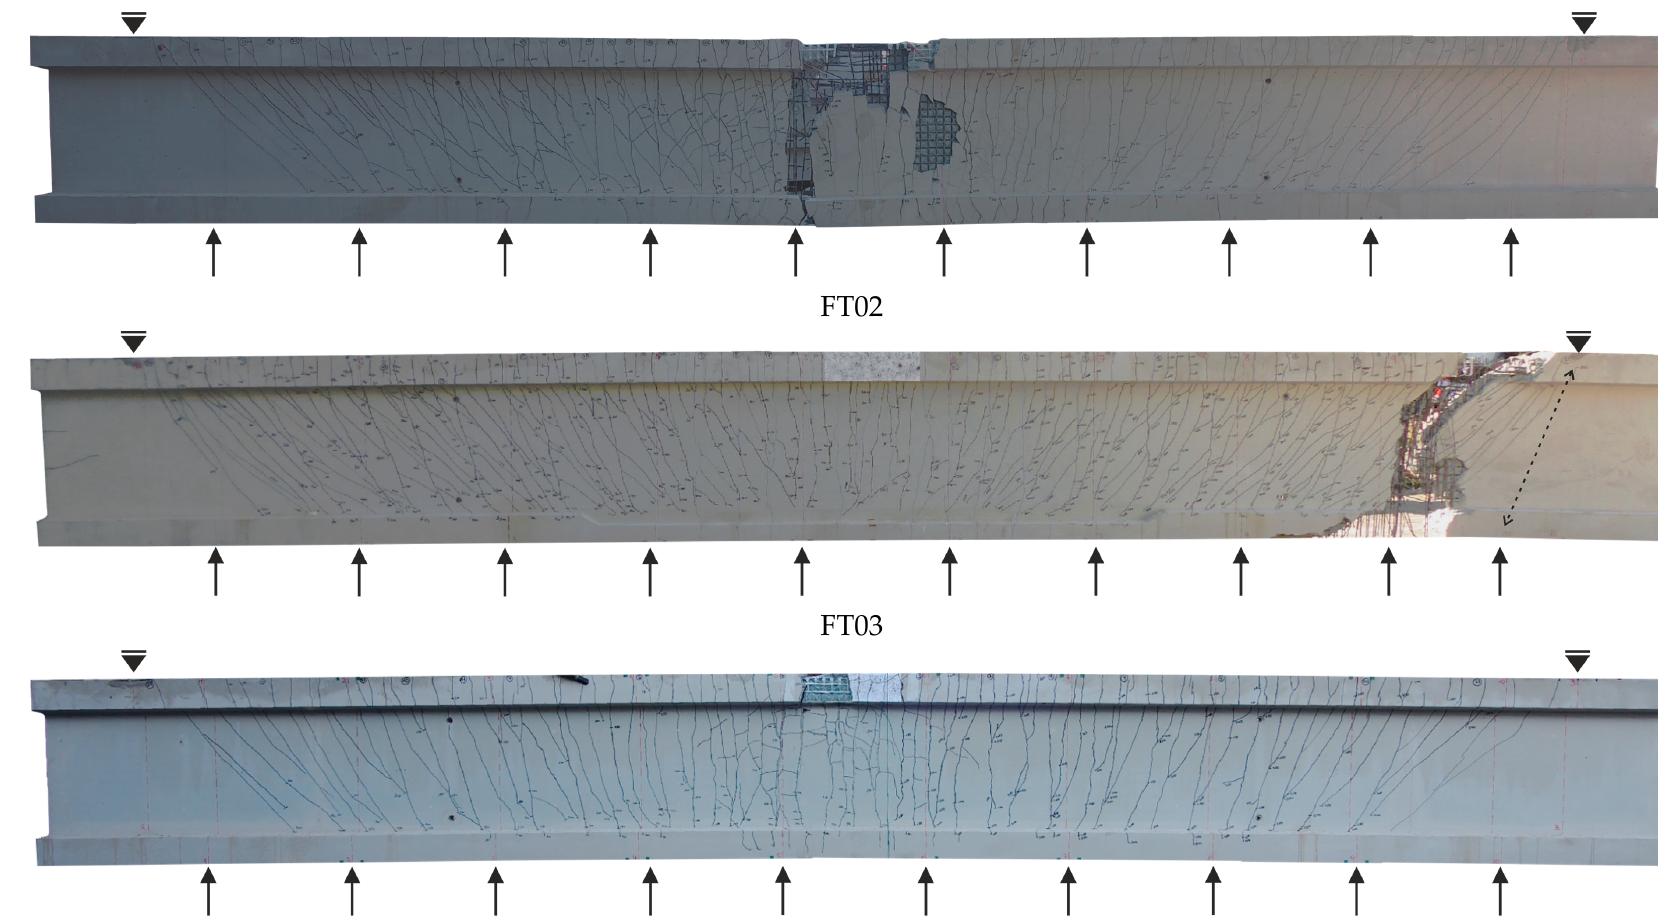
Figure 11. Crack pattern of beams FT01–FT03 after failure.